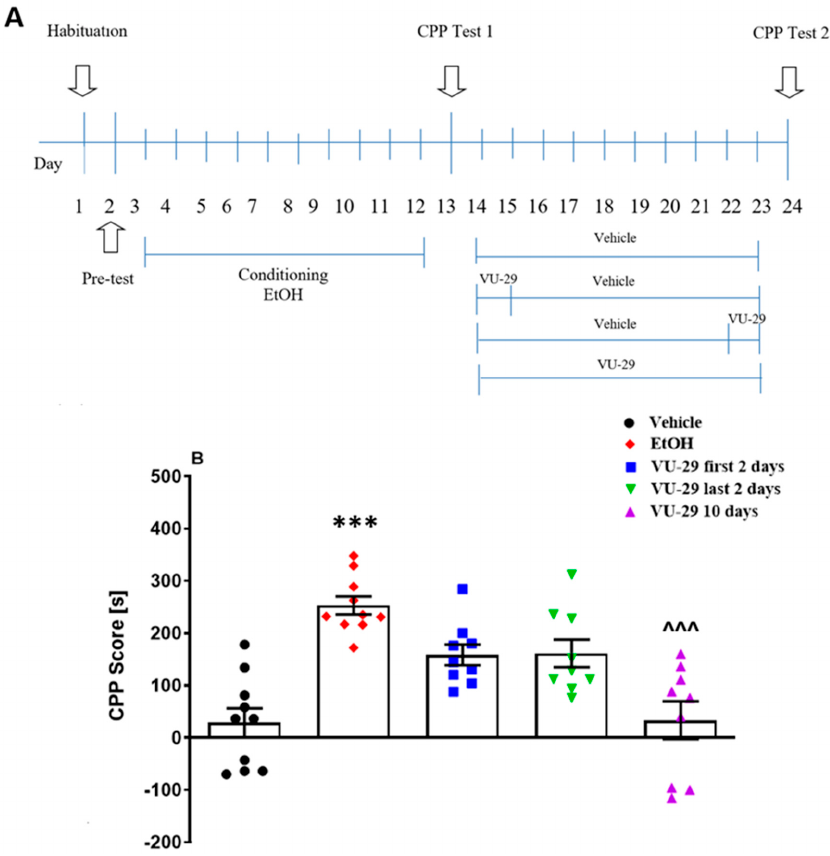
Figure 2. Experimental design for the effect of VU-29 administered in three different combinations on long-time maintenance of ethanol-induced CPP ( A ). Data are shown as post-conditioning minus pre-conditioning time (s) spent in the drug-associated compartment in the CPP Test 2 ( B ). Dots represent individual measurements, the central horizontal mark is the mean, and error bars represent SEM. *** p < 0.001 vs. vehicle; ^^^ p < 0.001 vs. ethanol-treated group.